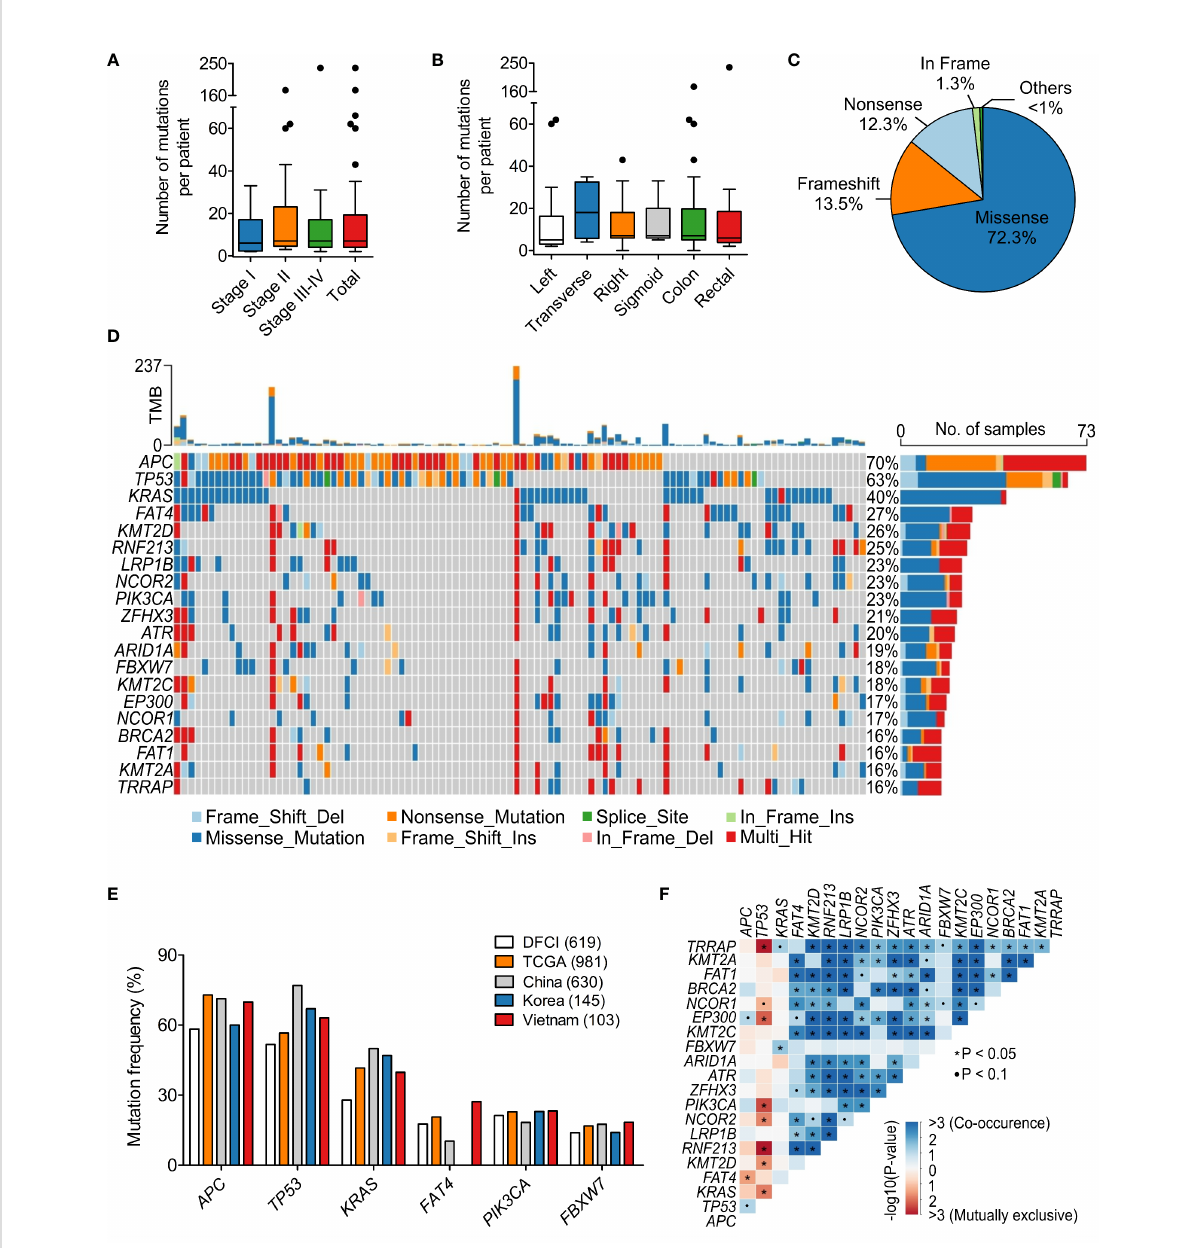
FIGURE 2 Mutational spectrum of 95 genes in the Vietnamese colorectal cancer patients. (A) The average number of tumor-derived mutations was 7 mutations per patient and not different by stage. (B) The mutation burden was not different by the tumor site. (C) Pie chart showing the distribution of mutation classes identi fi ed in 95 genes. (D) The top 25 signi fi cantly mutated genes in our cohort. (E) Mutation frequency of top mutated genes in our cohort was compared with published datasets of Caucasian and Asian cohorts. (F) Mutually exclusive and co-occurring mutated genes in our dataset. *P < 0.05; Kruskal-Wallis and post hoc Dunn ’ s test for (A, B)